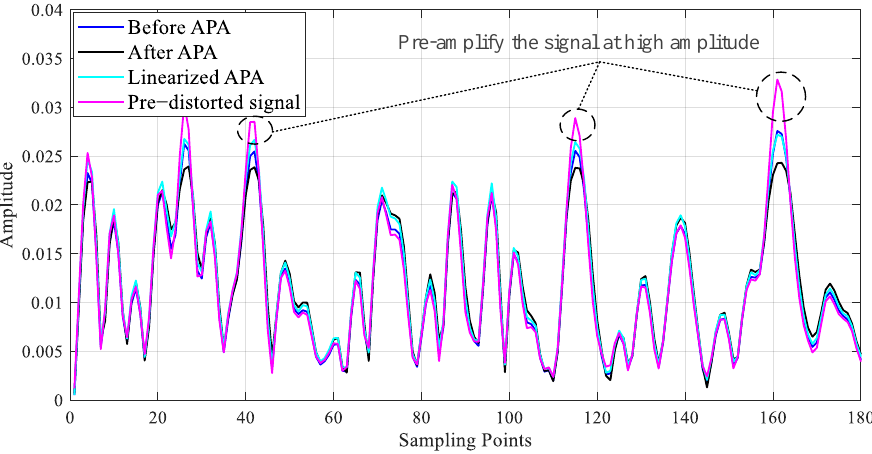
Figure 13. Time domain indication of the pre-distorted signal. Empirically and based on several attempts to obtain the minimum normalized mean square error